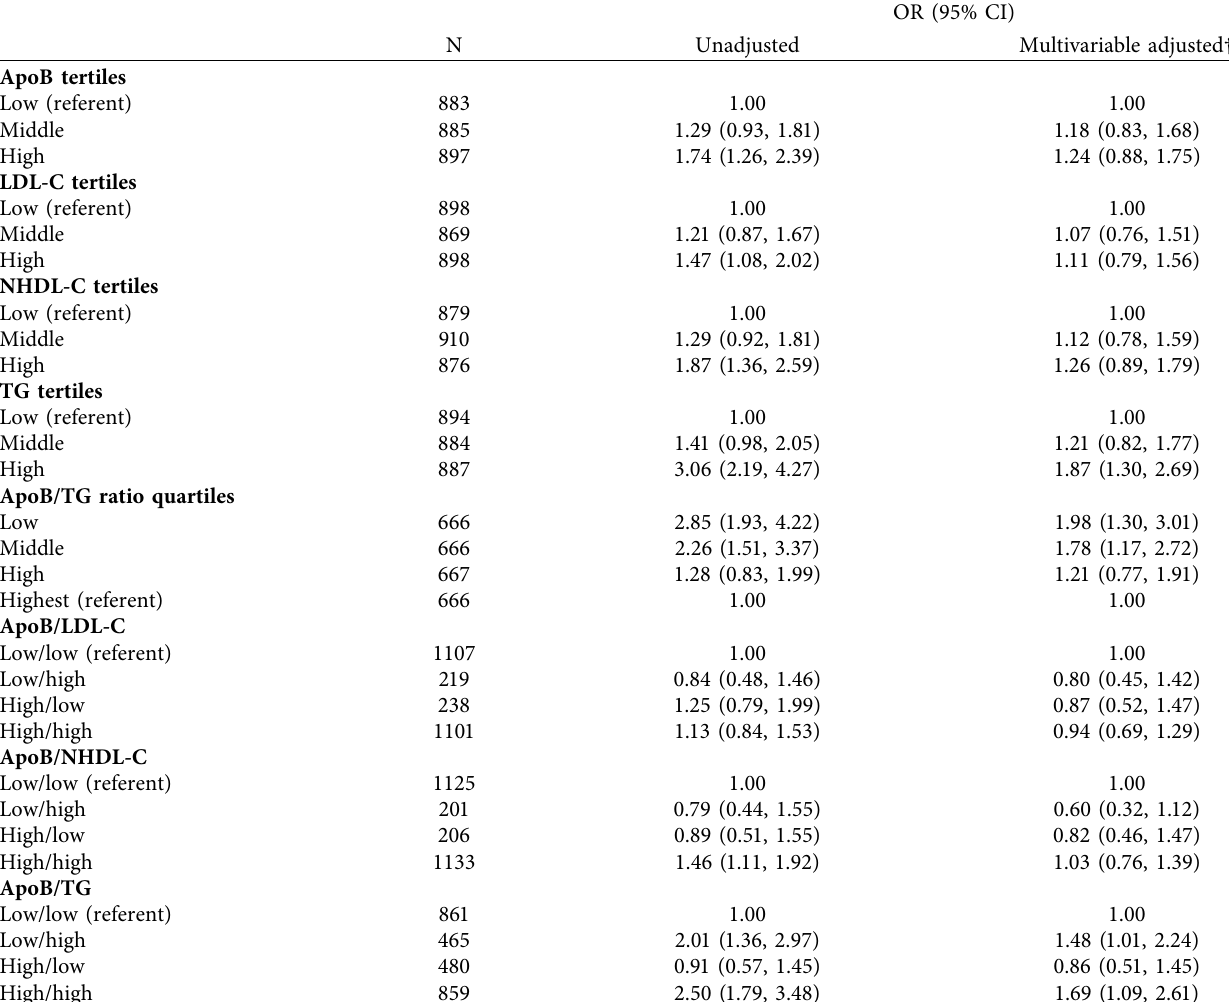
Table 4: ApoB cholesterol levels and concordance/discordance between ApoB and cholesterol categories in relation to odds of Y25 moderate-severe NAFLD ∗